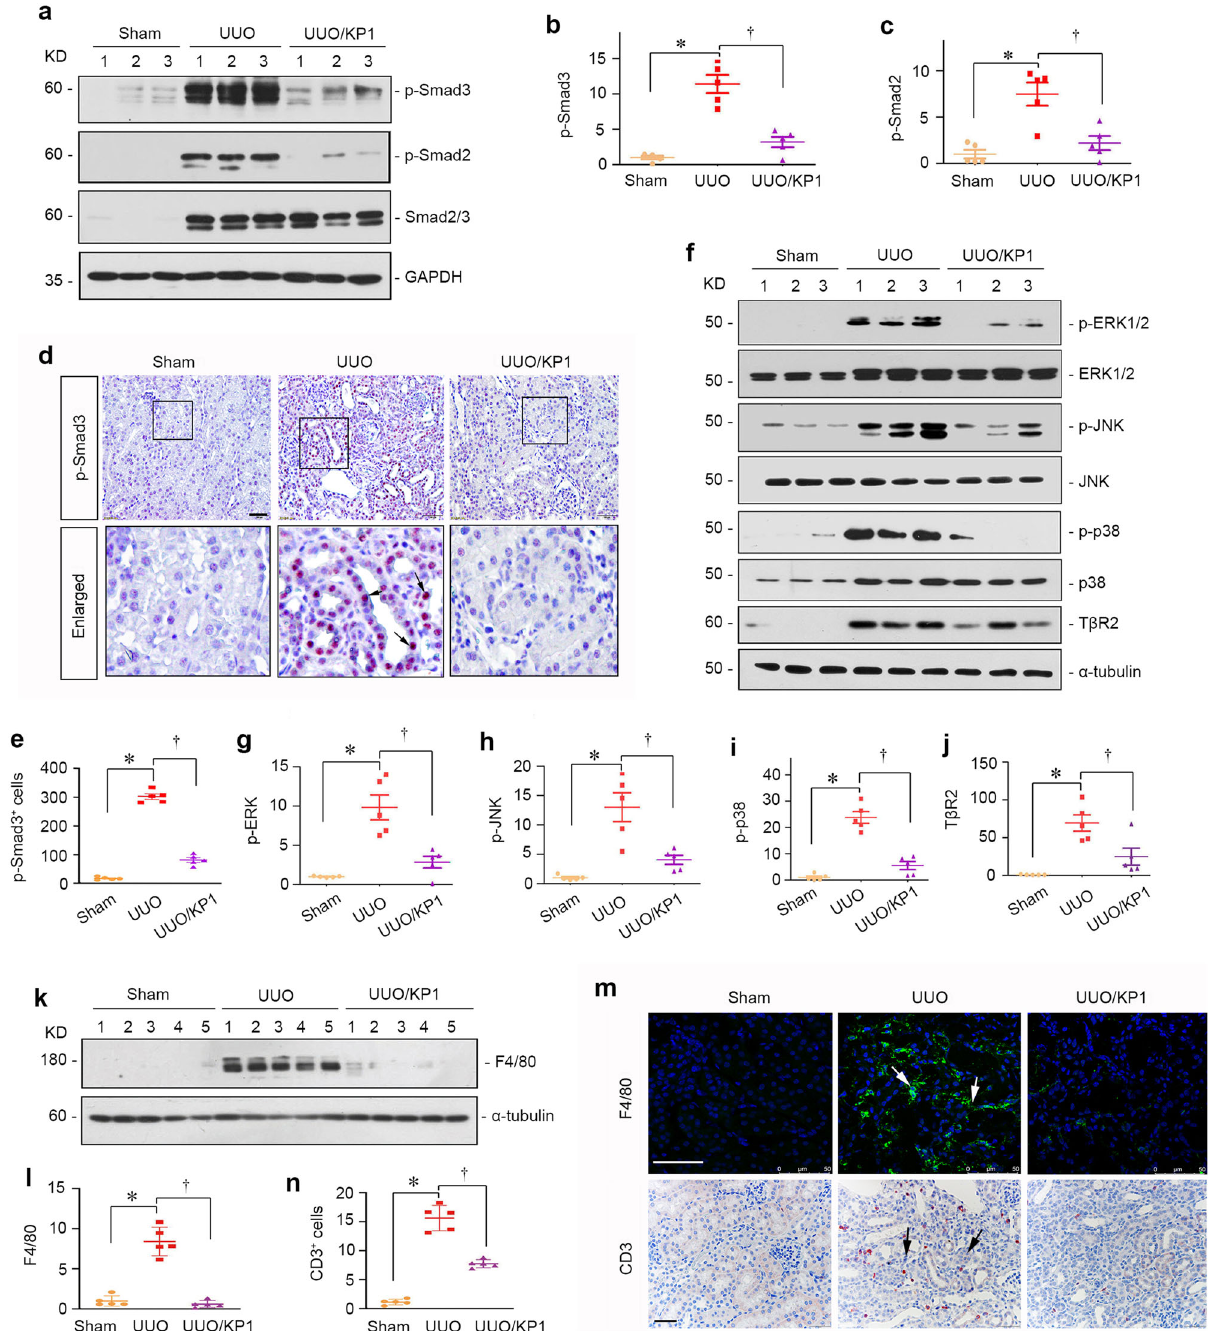
Fig. 7 KP1 blocks TGF- β signaling and inhibits renal in fl ammation in UUO mice. a – c KP1 inhibited activation of Smad signaling in the UUO kidney. Representative Western blot ( a ) and quantitative data of p-Smad3 ( b ) and p-Smad2 ( c ) in the obstructed kidney are shown. P values (from left to right): 0.003, 0.003 (p-Smad3); < 0.001, 0.001 (p-Smad2). n = 5 biologically independent animals. d Immunohistochemical staining of p-Smad3 in the obstructed kidney in different groups as indicated. Arrows indicate the nuclear staining of p-Smad3. Scale bar, 50 µ m. e Quantitative data of p-Smad3 positive cells number. P values (from left to right): <0.001, <0.001. n = 5 biologically independent animals. f KP1 inhibited MAPK activation and T β R2 expression in UUO. g – j Quantitative data of p-ERK1/2 ( g ), p-JNK ( h ), p-p38 ( I ), and T β R2 ( j ). P values (from left to right): 0.013, 0.022 (p-ERK); 0.020, 0.049 (p-JNK); 0.001, 0.001 (p-p38); <0.001, 0.004 (T β R2). n = 5 biologically independent animals. k , l Representative Western blot ( k ) and quantitative data of F4/80 ( l ). P values (from left to right): 0.001, 0.001. n = 5 biologically independent animals. m Immunohistochemical staining of CD3 and immuno fl uorescence of F4/ 80 are shown. Scale bar, 50 µ m. n Quantitative data of CD3 positive T cells number. P values (from left to right): <0.001, 0.002. n = 5 biologically independent animals. Data are presented as mean values± SEM. P values were calculated by one-way ANOVA with Fisher ’ s LSD post hoc test ( c , e , j ) or Dunnett ’ s T3 test ( b , g – i , l , m ). Source data are provided as a Source Data fi